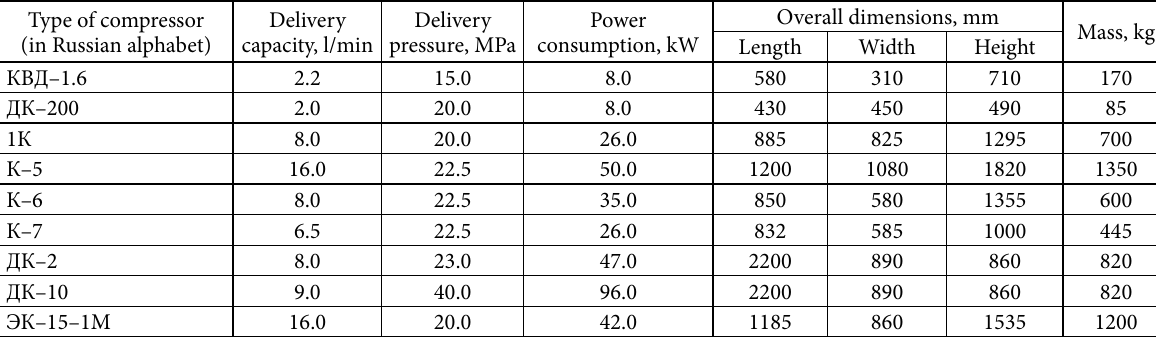
Table 2. Technical characteristics of high-pressure compressors Type of compressor (in Russian